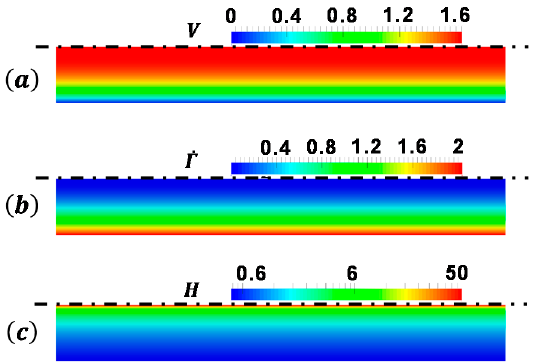
Figure 3. Contours of ( a ) velocity, ( b ) shear rate and ( c ) apparent viscosity in the straight pipe. The upper boundary is the axis of symmetry and the lower boundary is the wall with no-slip condition. The wall temperature is θ w = 1 and the inlet Re gen is 0.1.